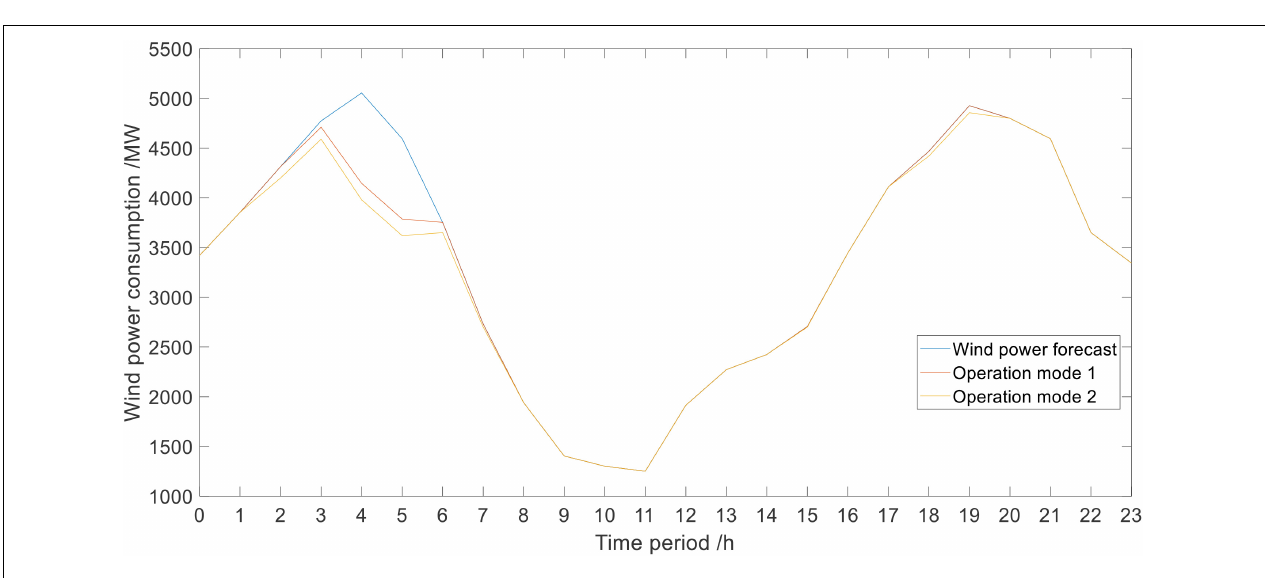
FIGURE 15 | Wind power consumption results under different modes.